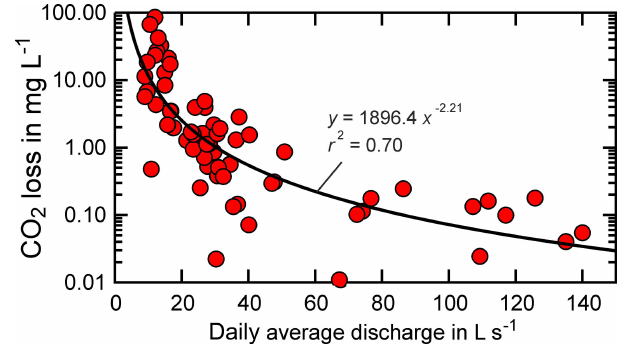
Figure 4. Modelled CO 2 loss via outgassing upstream of the mea- surement point (UHL) versus daily average discharge. Modelling results correspond to modelling with groundwater